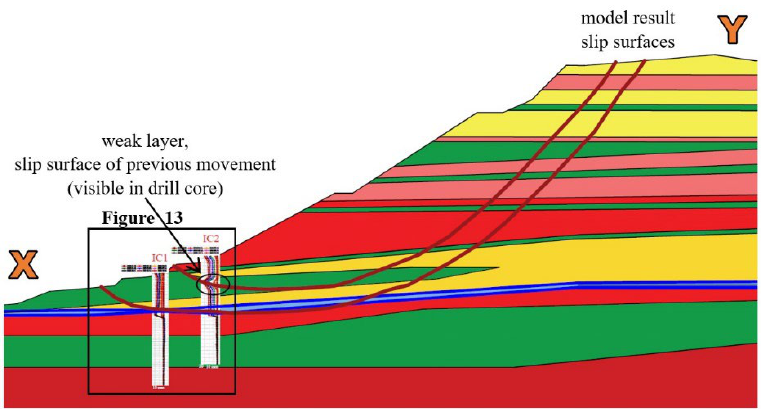
Figure 14. Slip surfaces of the model results and IC1 and IC2 displacements.